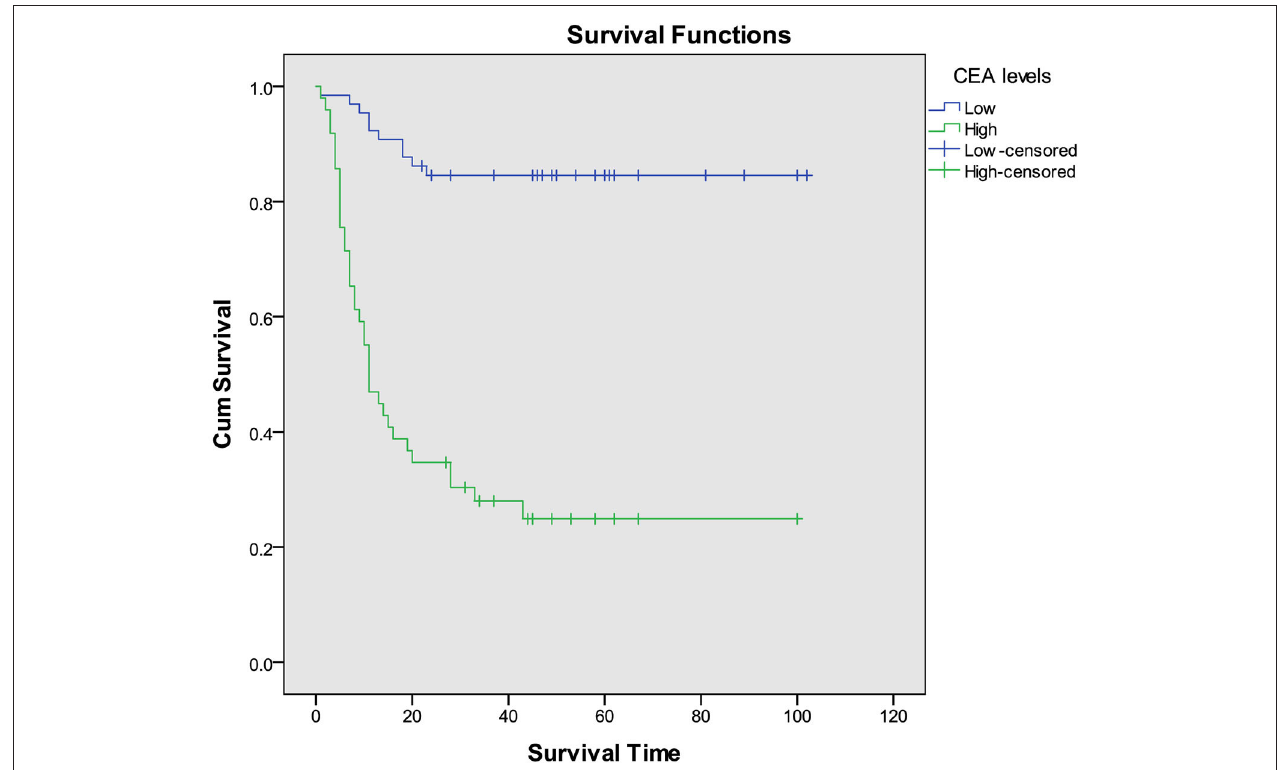
FIGURE 2 | Kaplan–Meier survival analysis of COVID-19 patients with different CEA levels.